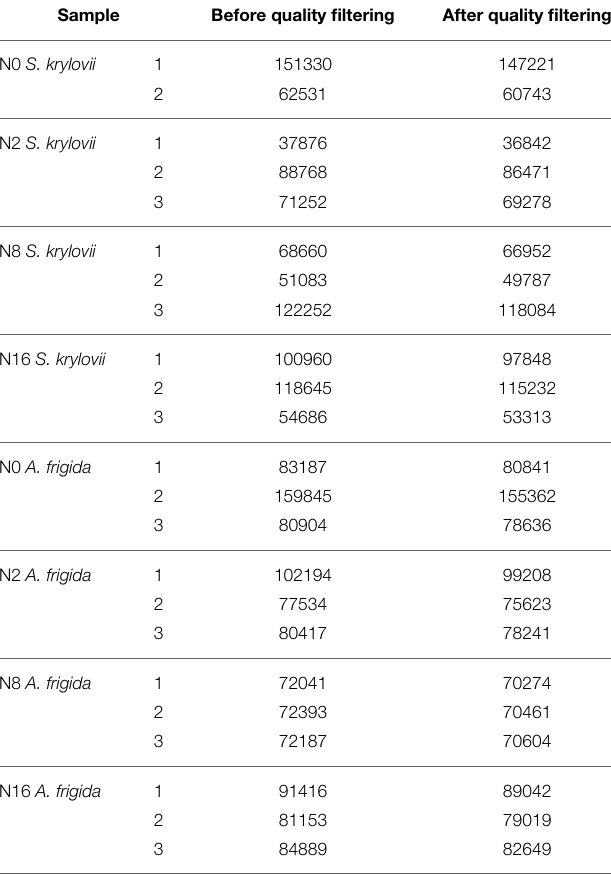
TABLE A1 | The number of reads before and after quality filtering.